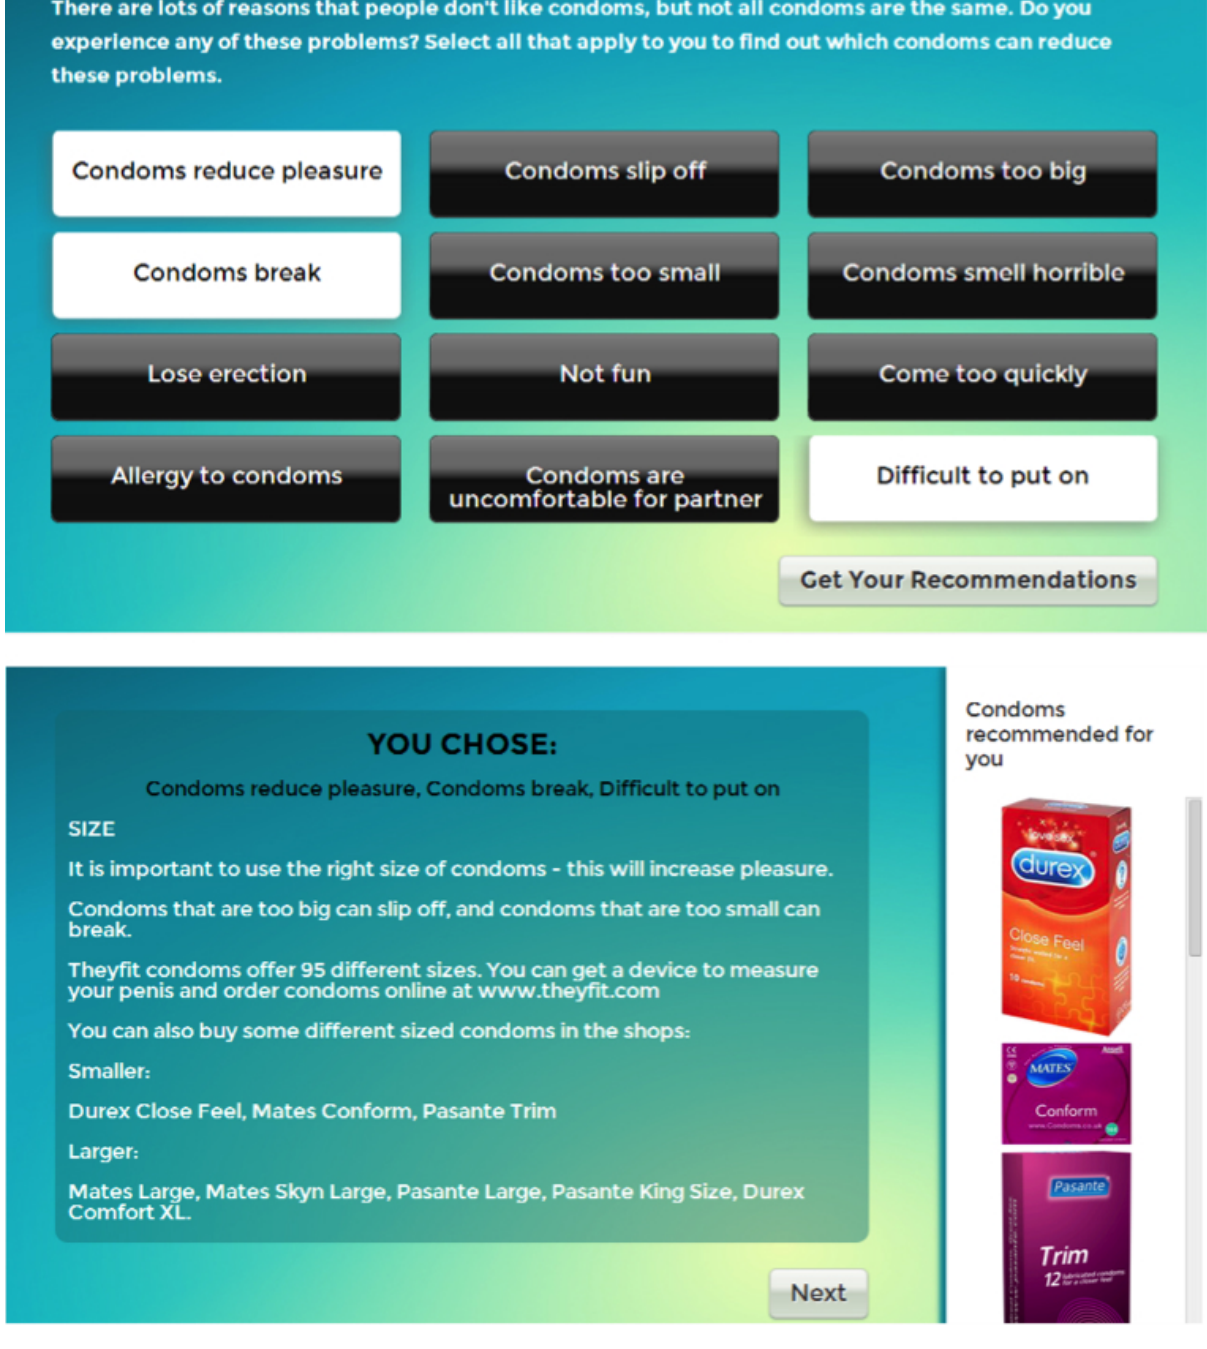
Figure 4. Condoms: Tailored for you – tailored feedback on selected barriers to condom